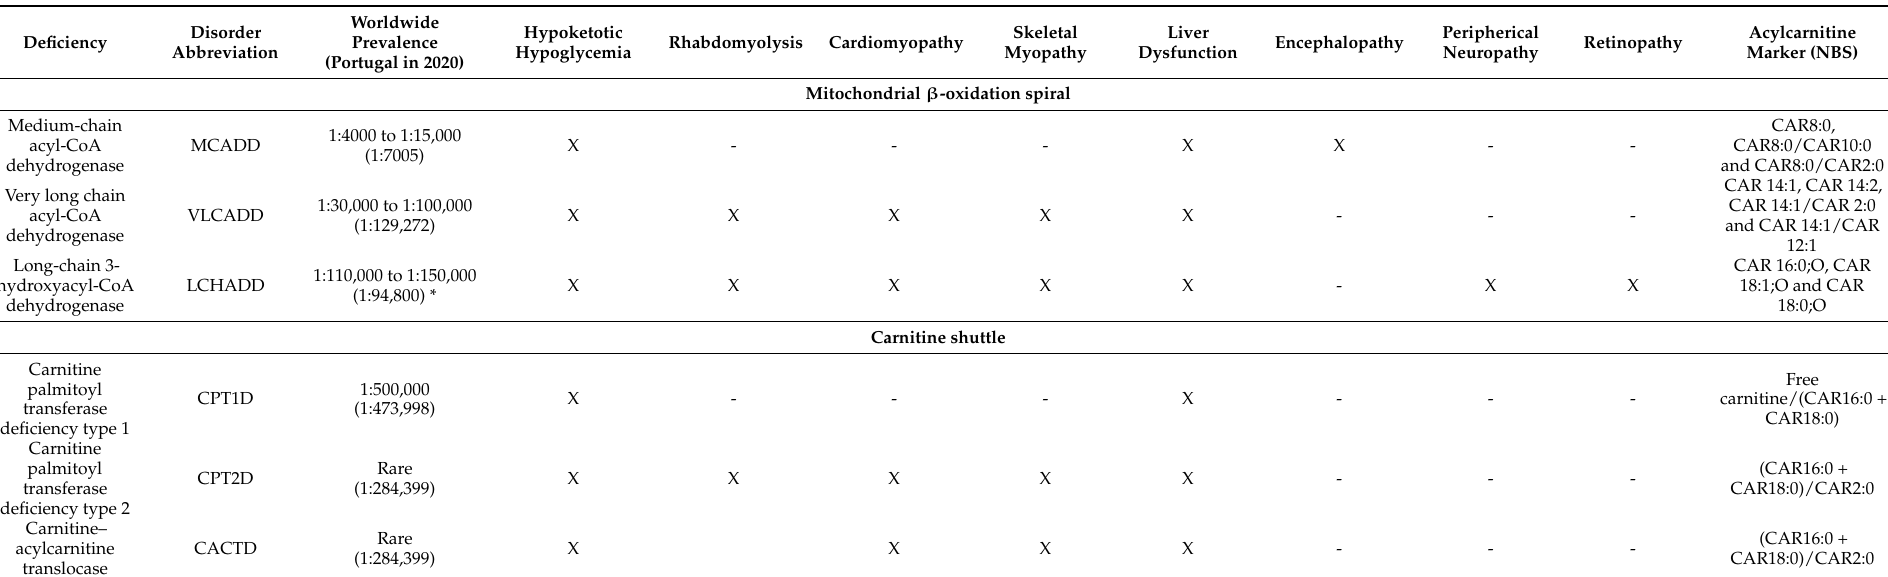
Table 1. Some of the defects of the mitochondrial fatty acid β -oxidation with worldwide and Portuguese prevalence, clinical presentations, and newborn screening (NBS) acylcarnitine profile. Adapted from Sim et al. [15], Knottnerus et al. [2], Merritt et al. [31], and El-Gharbaway et al. [42].